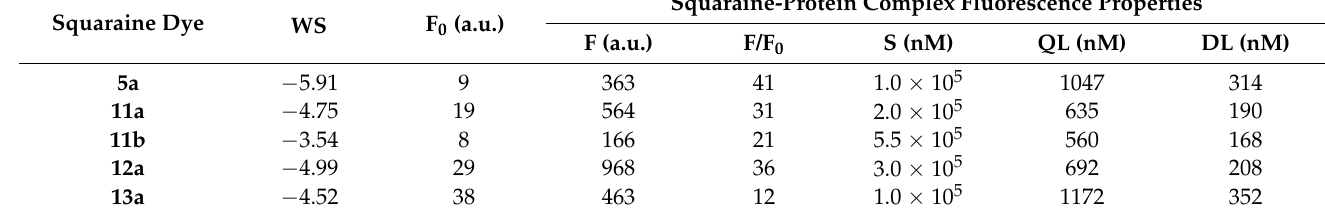
Table 4. Determined squaraine–albumin interaction fluorescence of squaraine dyes 5a , 11a , b , 12a , and 13a [fluorescence intensity in the absence of protein (F 0 ), squaraine fluorescence intensity observed at the highest concentration of protein (F), ratio between these last two parameters (F/F 0 ), sensitivity (S), and quantification and detection limits (QL and DL, respectively)]. Predicted water solubility (WS) of squaraine dyes is given in log (mol/L). Squaraine-Protein Complex Fluorescence F 0 (a.u.)